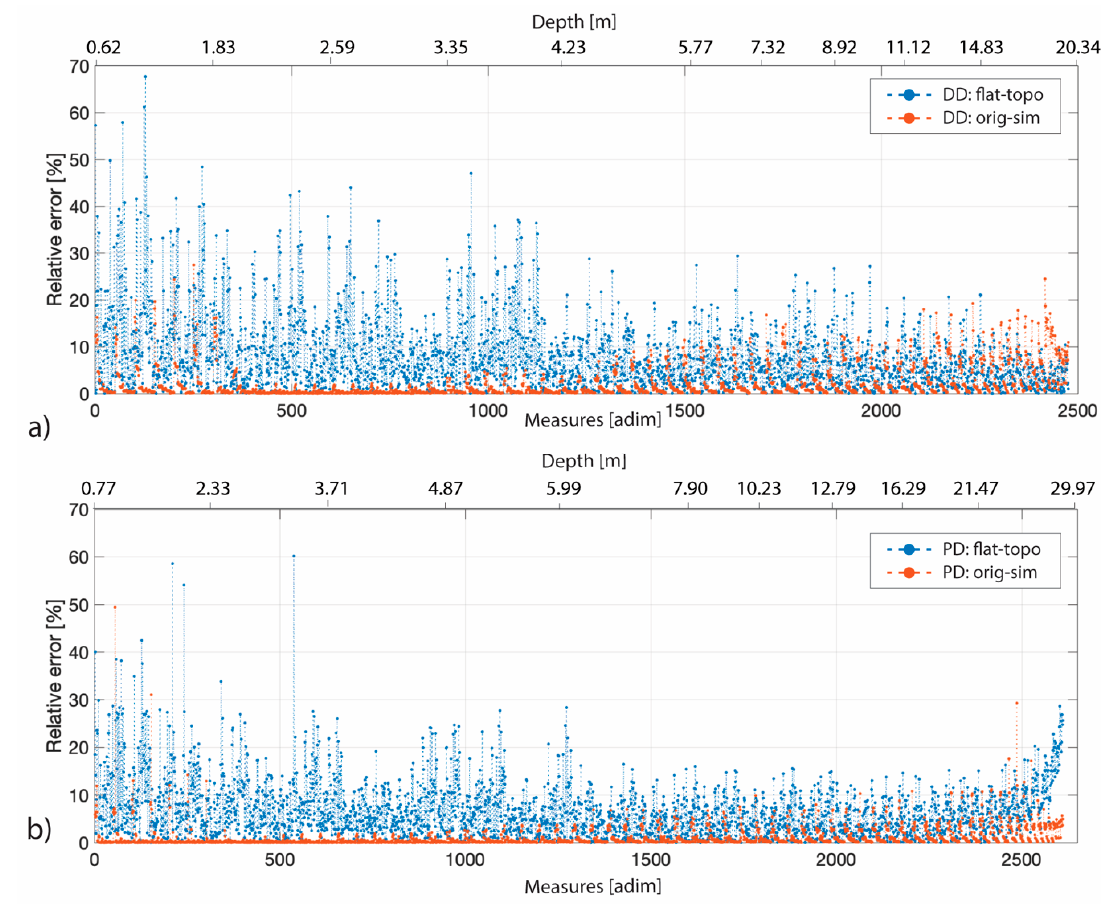
Figure 12. Geometric factor percentage relative error—with respect to both the depth (upper axis) and the number of measures ordered according to the quadripole investigation depth (lower axis)—between the flat and topo dataset (in blue), and between the original and the mean simulated datasets (in orange). ( a ) Both trends refer to the DD array while in ( b ) to the PD one.